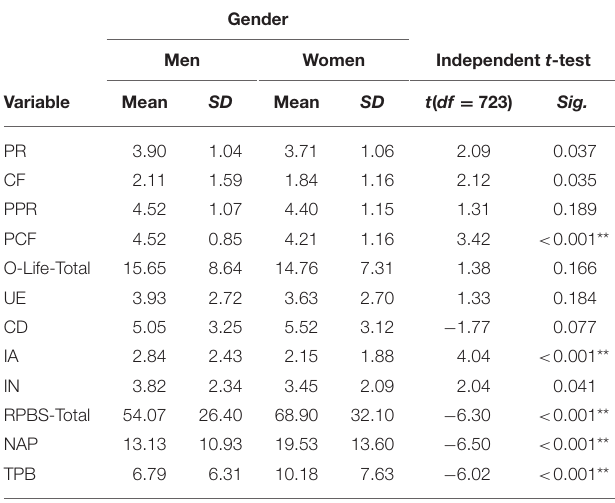
TABLE 2 | Means, standard deviations and t -test outcomes for all study variables by gender.